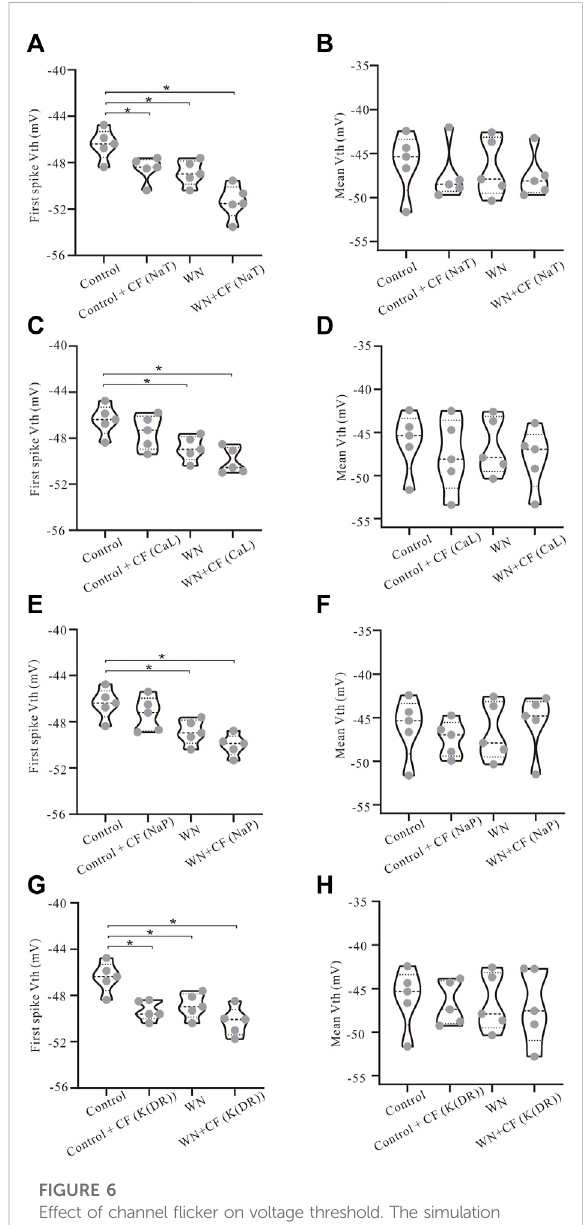
FIGURE 6 Effect of channel fl icker on voltage threshold. The simulation data presented below were recorded with current ramp peak of 1 nA. (A) V th forthe fi rstspikewashyperpolarizedinControl+CF(NaT),WN and WN + CF (NaT). (B) No signi fi cant hyperpolarization of V th was observed in mean values of V th for all spikes. (C) V th for the fi rst spike was hyperpolarized in both WN and WN + CF (CaL). (D) No signi fi canthyperpolarizationwasobtainedinmeanvaluesofV th forall spikesinControl+CF(CaL),WNandWN+CF(CaL). (E) V th forthe fi rst spike was lowered in both WN and WN + CF (NaP). (F) There was no substantial hyperpolarization of mean values of V th in Control + CF (NaP),WNandWN+CF(NaP). (G) Control+CF(K(DR)),WNandWN+ CF(K(DR))inducedthesigni fi cantloweringofV th forthe fi rstspike. (H) K(DR)+CF did not signi fi cantly alter the mean V th for all spikes with or without WN. * p <